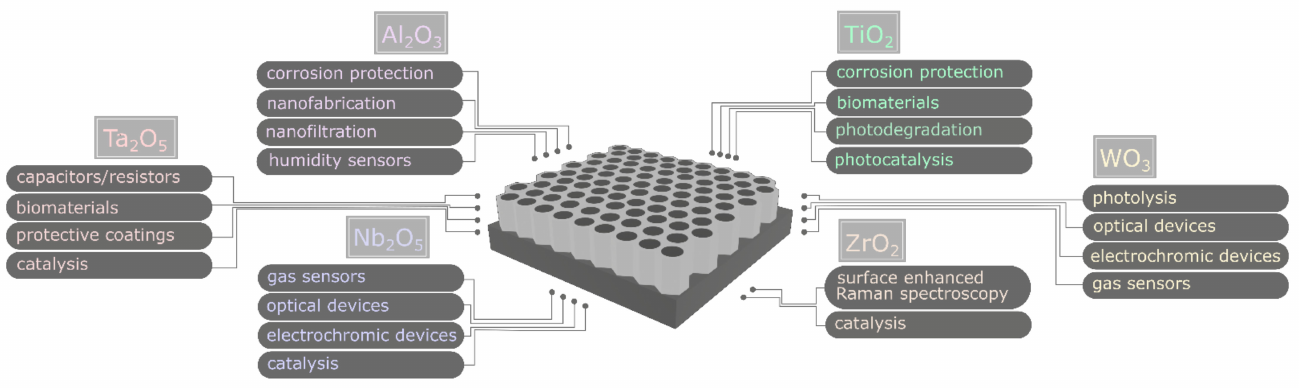
Figure 2. Most significant applications of selected nanostructured metallic oxides prepared by